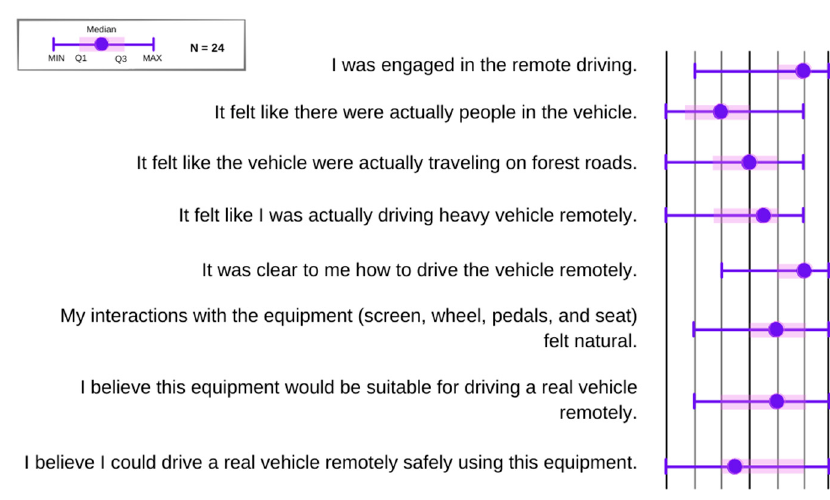
Figure 4. Results of the final questionnaire: overall user experience with the system.